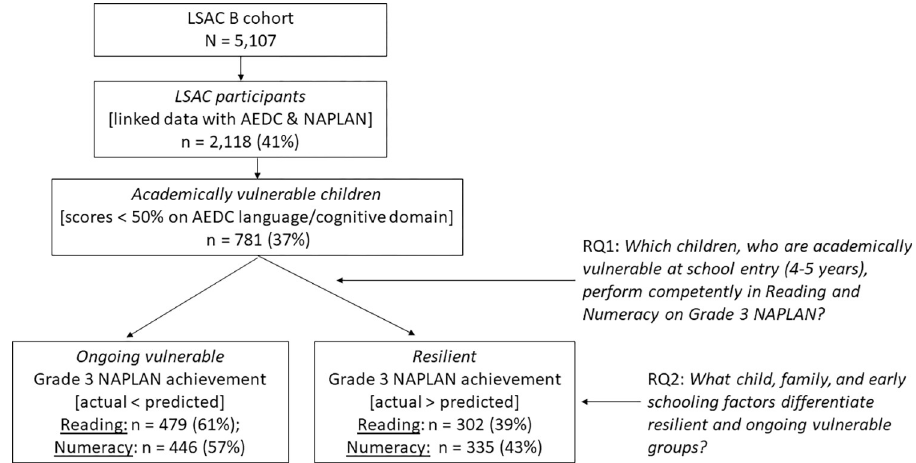
Fig 1. Participant sample and research questions at each stage of the study. LSAC B: Longitudinal Study of Australian Children Baby cohort; AEDC = Australian Early Development Census; NAPLAN = National Assessment Program Literacy and